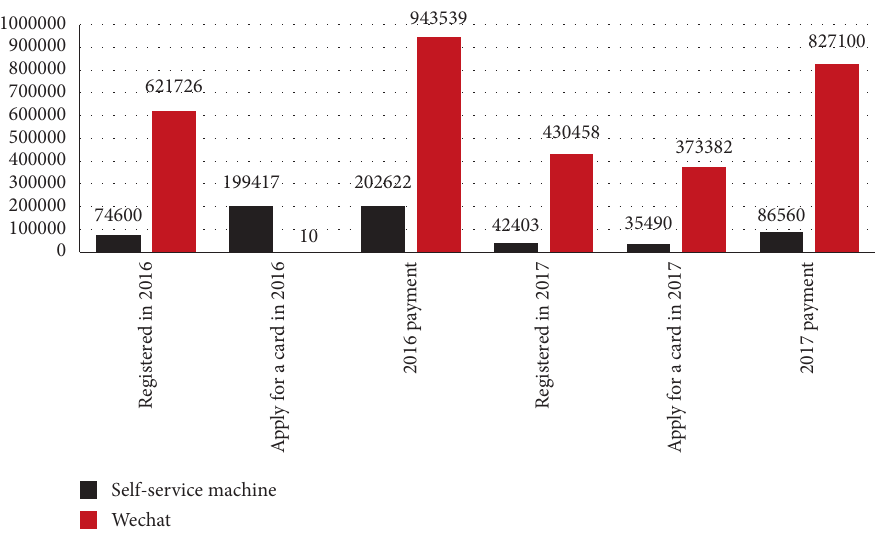
Figure 2: Self-service machines from 2016 to 2017 compared with WeChat service capacity.